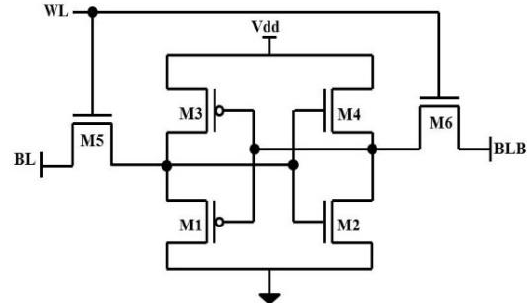
Figure 3. Traditional 6T-SRAM cell [24].